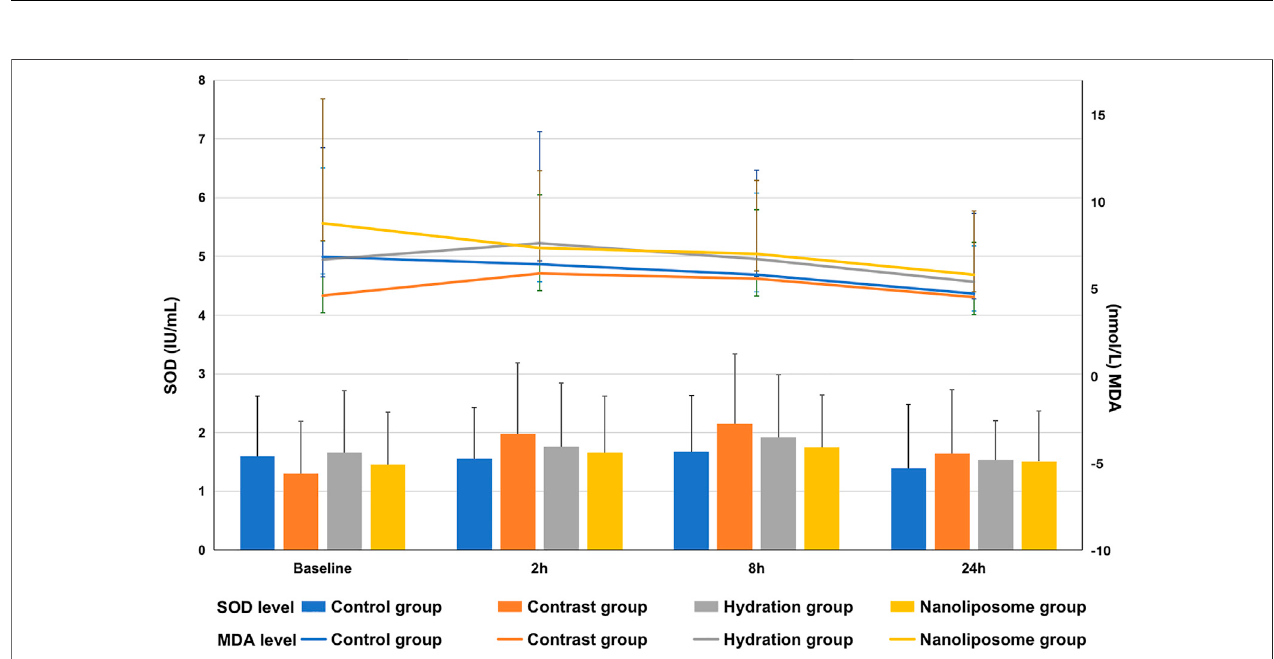
FIGURE 5 | The contents of apoptosis index Bcl-2/Bax ratios in four groups were detected by ELISA. Bcl-2 (cid:2) B-cell lymphoma/leukemia 2; Bax: Bcl-2 subfamily, pro-apoptotic factor. Values are expressed as mean ± SD. *Compared with the contrast group, p < 0.05. **Compared with the contrast group, p < 0.01. # Compared with the hydration group, p < 0.05. ## Compared with the hydration group, P < 0.01.